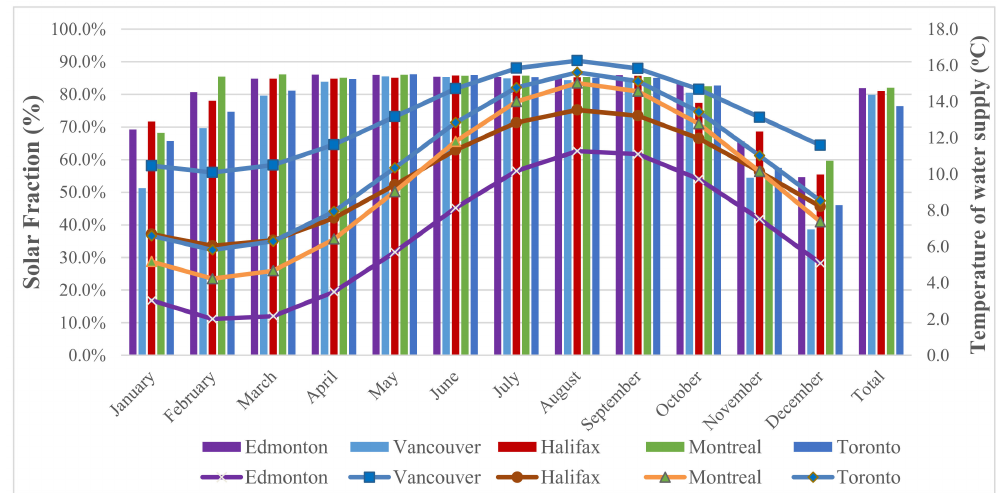
Figure 17. Monthly SF of MCPVT-HP system in different cities as a function of water main supply temperature.